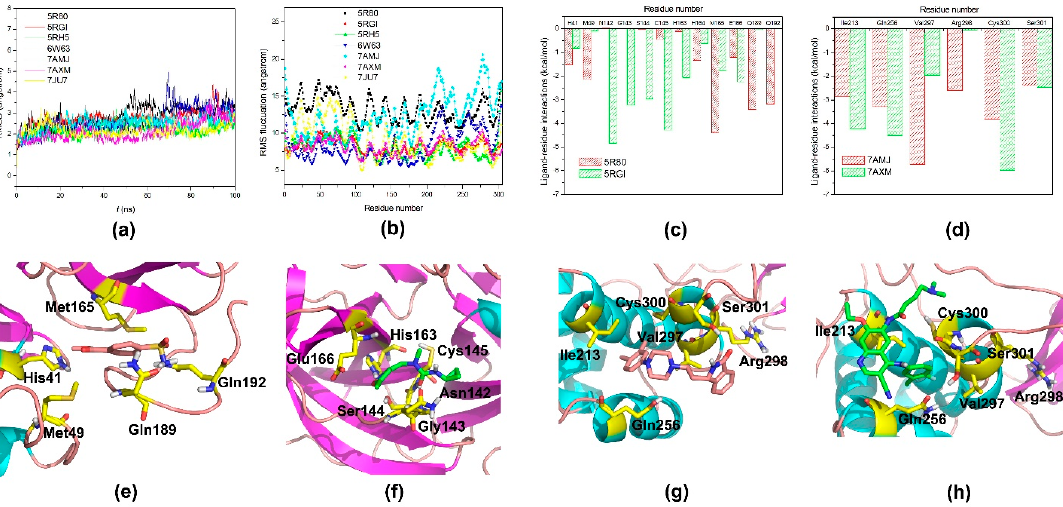
Figure 6. The dynamics, energy and structure comparison of MD simulations. ( a ) The RMSD values of C α atoms with respect to the first snapshots as a function of time; ( b ) The RMSF of backbone atoms versus residue number; ( c ) Binding energy contributions from the key residues of M pro in 5R80 and 5RGI; ( d ) Binding energy contributions from the key residues of M pro in 7AMJ and 7AXM; ( e – h ) Comparisons of the averaged structures for 5R80, 5RGI, 7AMJ and 7AXM. MM/GBSA free energy decomposition was employed to obtain ligand-residue in- teraction spectra to insight into the interaction patterns of M pro with non-covalent bind- ers, Z369936976 from Group 1 (PDB code:5RGI) and Z18197050 from Group 2 (PDB code:5R80), as well as two allosteric modulators, PD-168568 (PDB code:7AMJ) and pe- litinib (PDB code:7AXM). The critical residues for ligands recognition were shown in